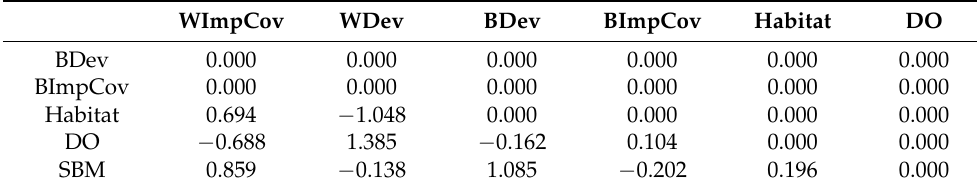
Table 6. Standardized indirect effects of sub-watershed developed (WDev), buffer developed (BDev), sub-watershed impervious cover (WImpCov), buffer impervious cover (BImpCov), habitat and dissolved oxygen (DO) as provided by the final path analysis using SPSS ® AMOS